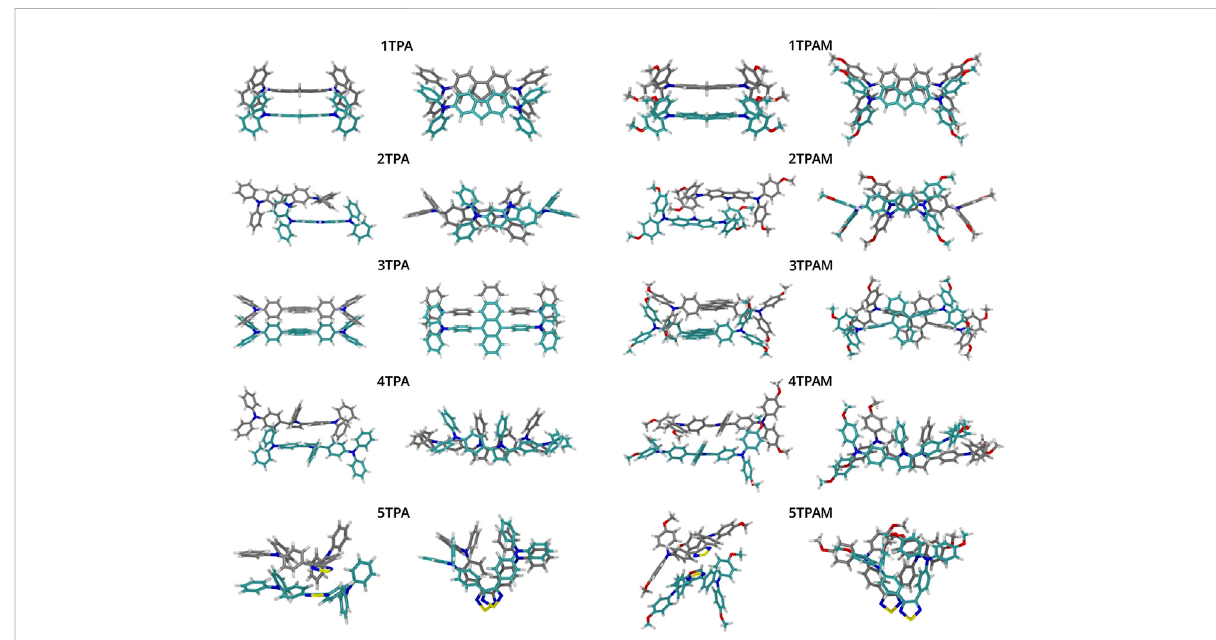
FIGURE 8 Optimized geometrical structures of the dimers obtained with